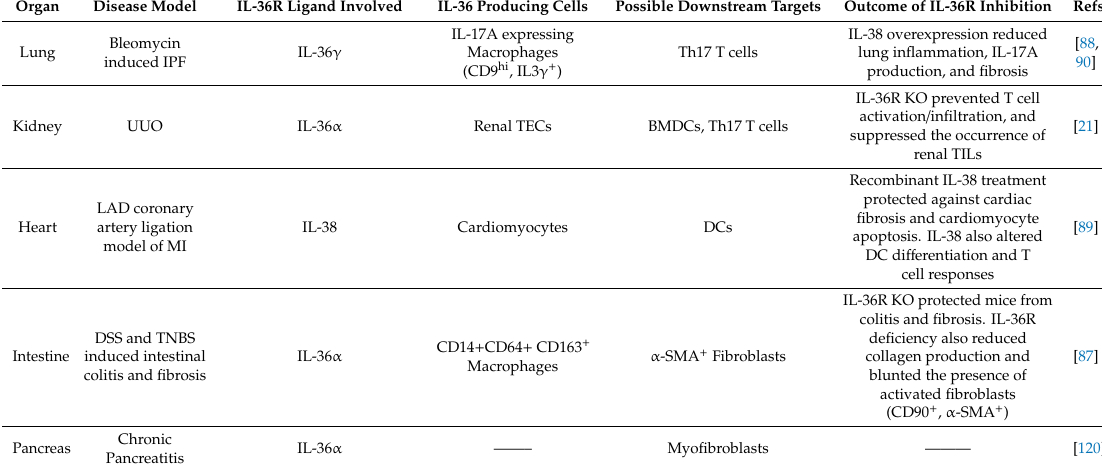
Table 1. Summary of interleukin (IL)-36 / IL-36 receptor (IL-36R) mediated tissue